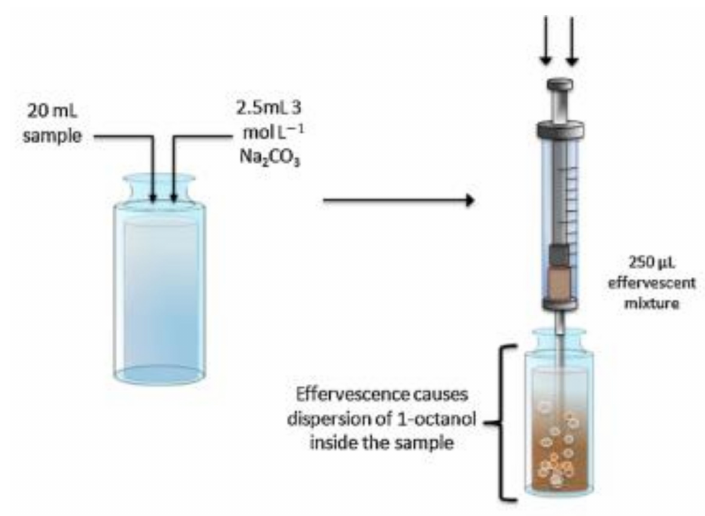
Figure 5. Schematic diagram of the e ff ervescence-assisted dispersive liquid–liquid extraction (DLLME). Adapted with permission of Elsevier from reference